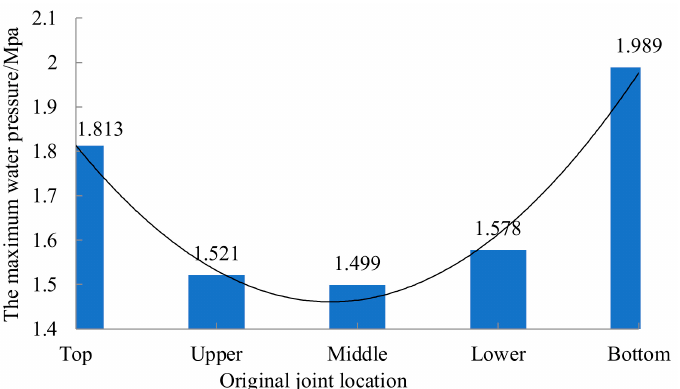
Figure 7. The maximum water pressure of rock specimen with different joint locations.